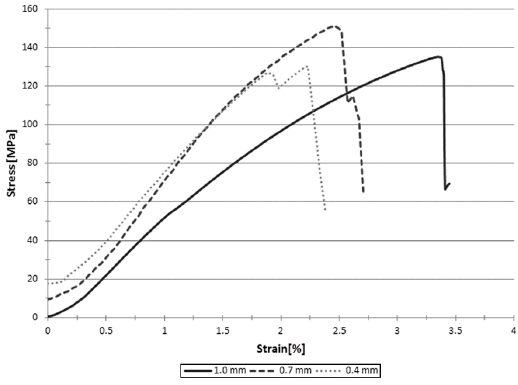
Figure 17. Representative figure of broken sample with 0.7mm section diameter.